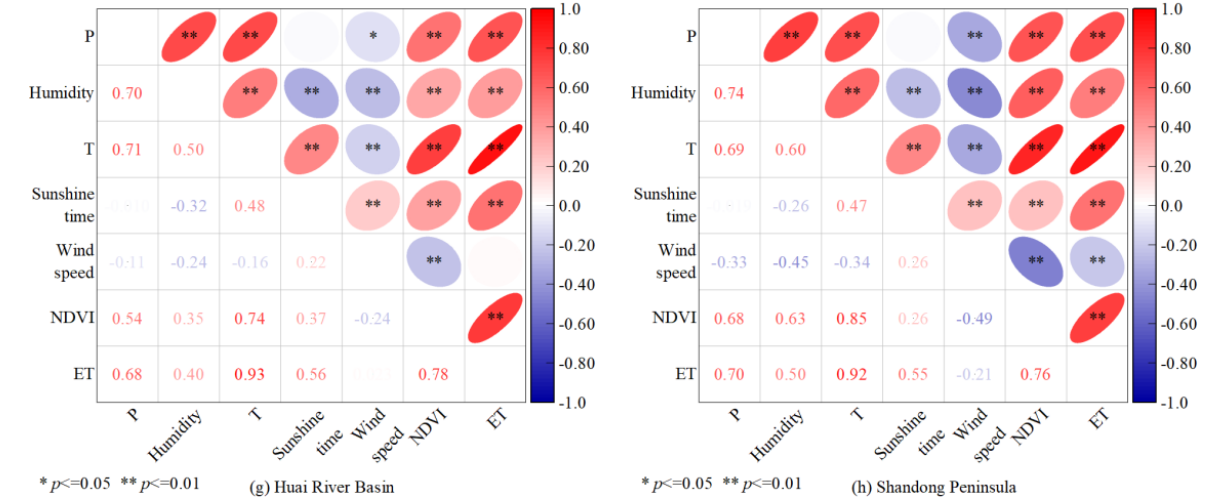
Figure 3. Pairwise correlation coefficients between driving factors and actual evapotranspiration in the HRB.